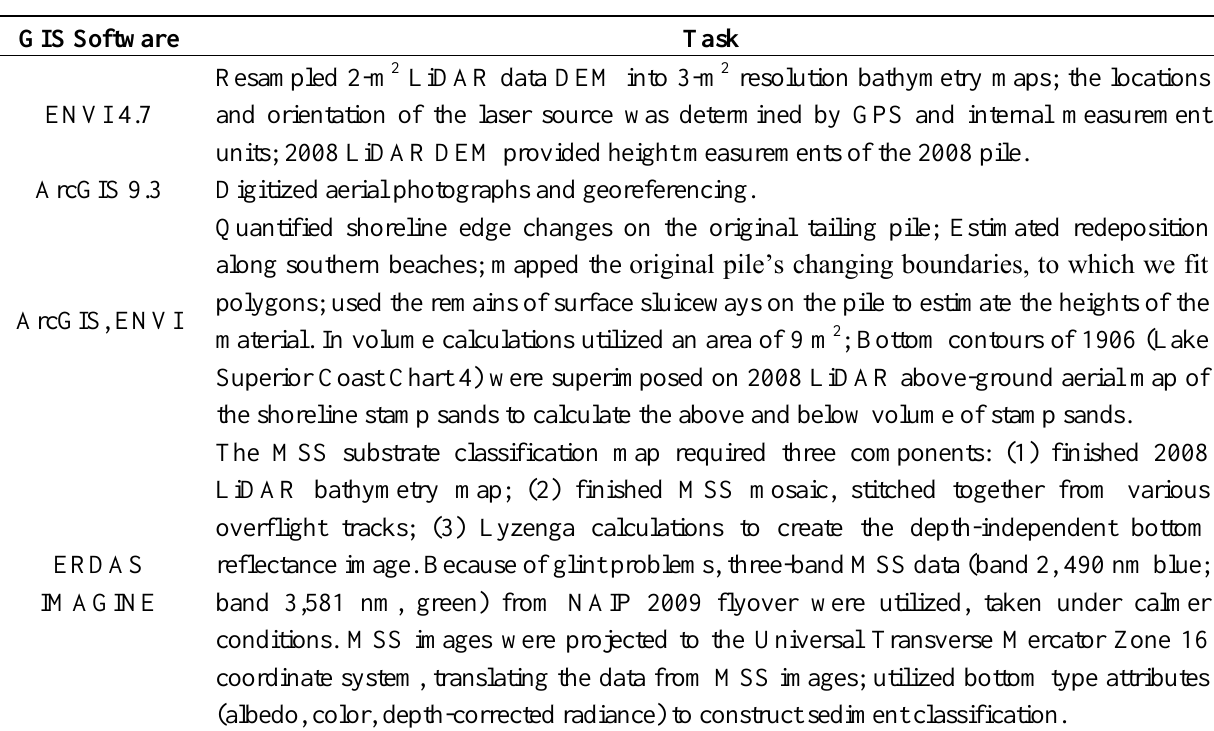
Table 1. GIS applications to Grand Traverse Bay